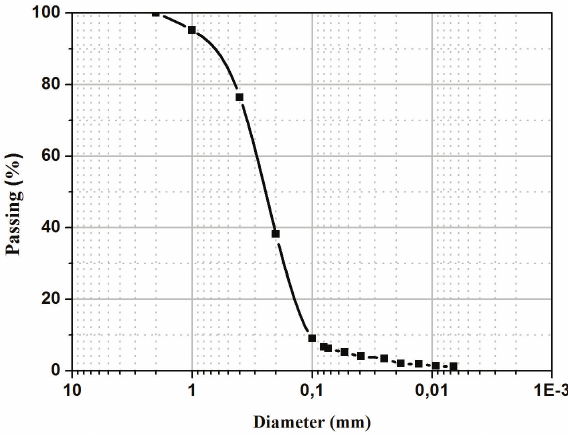
Figure 1: Granulometric curve of the collapsible soil.